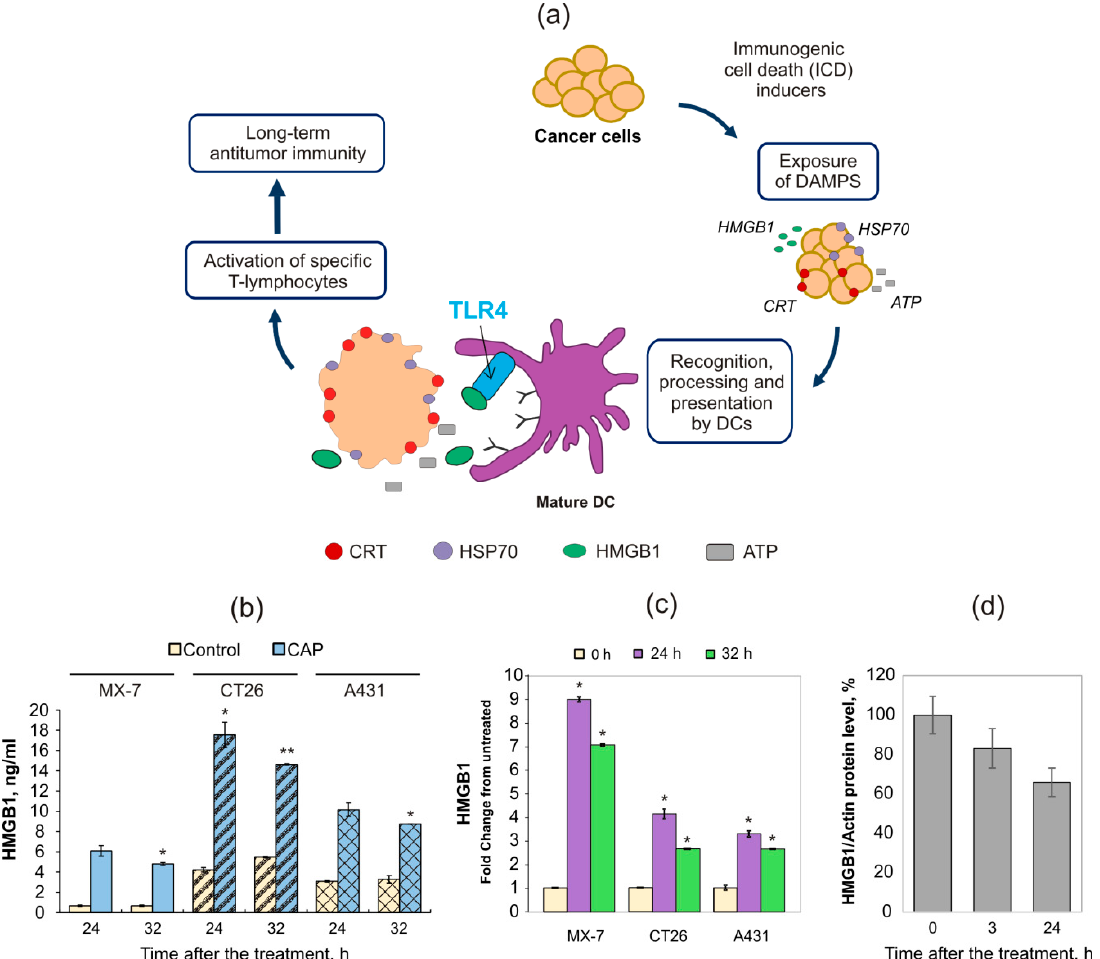
Figure 3. Plasma induces the death of irradiated cells with the appearance of immunogenic cell death (ICD) hallmarks. ( a ) The scheme of ICD-related molecular transformations and cellular signaling. DCs—dendritic cells; DAMPS—danger associated molecular patterns. ( b – d ) Analysis of extracellular ( b , c ) and intracellular (d) HMGB1. MX − 7, CT26 and A431 cells were exposed to CAP for 1 min, and 24 as well as 32 h later HMGB1 was assayed in the culture medium. ( c ) Data are presented as the fold change in the HMGB1 amount compared to the non-treated control. ( d ) Cellular HMGB1 in the CAP-treated samples; relative quantification of HMGB1 / α -actin according to the Western blot analysis of the HMGB1 expression in the MX-7 cell lysates. Student’s t -test was applied to compare the control and the experimental groups. Data are represented as the mean ± SEM, * p ≤ 0.05, ** p ≤ 0.01.